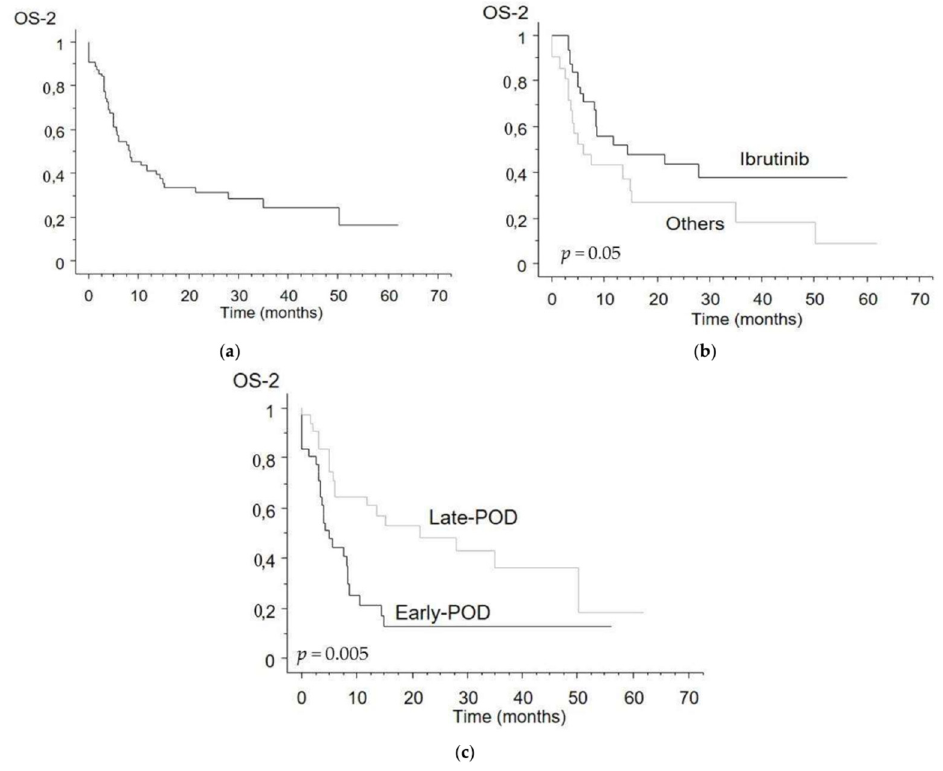
Figure 2. Overall survival from time of first relapse (OS-2) of MCL patients: ( a ) all 64 relapsed or refractory patients; ( b ) patients who had ibrutinib as second line ( n = 33) versus other treated patients ( n = 21); ( c ) patients experiencing early- ( n = 31) versus late-POD ( n = 33) after first line.